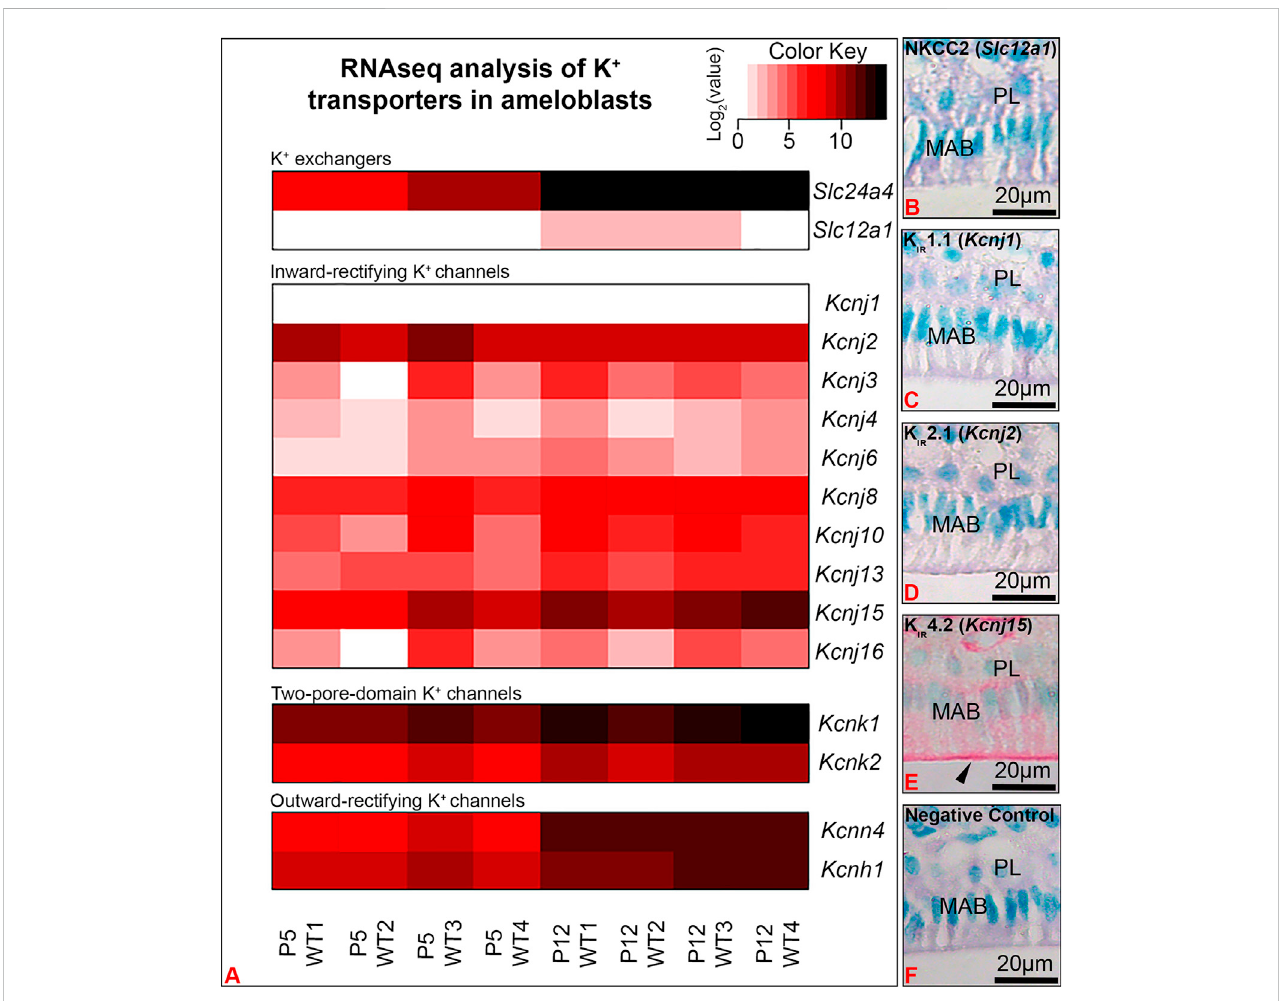
RNA-seq analysis showed Kcnj15 to be the most signi fi cantly upregulated inwardly rectifying K + channel in maturation (P12) as compared to secretory (P5) enamel organs. (A) A heat map represents the expression levels of K + transporters identi fi ed by RNA-seq in the P5 and P12 mouse fi rst molar enamel organs. Immunohistochemical staining of NKCC2 (Slc12a1) (B) , Kir1.1 (Kcnj1) (C) , Kir 2.1(Kcnj2) (D) were immunonegative in maturation ameloblasts (MAB), while Kir4.2 (Kcnj15) was immunopositive, with increased staining at the ameloblast apical border. Negative control (F) . PL. papillary